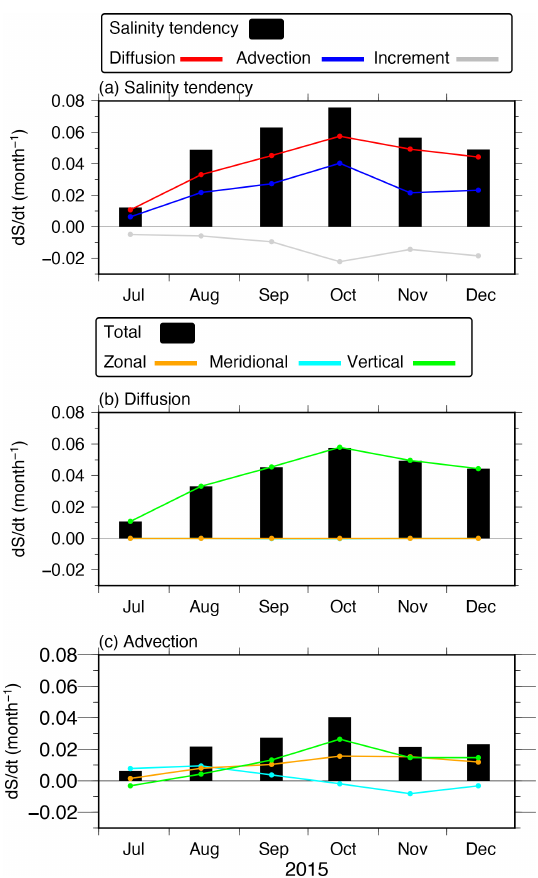
Figure A1. (a) Monthly mean for each term in the salinity budget equation (Eq. 5) averaged over the KE region in the intermediate layer (30–40 ◦ N, 140–160 ◦ E; 500–1000m depth) in the CTL run: the salinity tendency term (the LHS term; black bars), the salin- ity diffusion term (the first term on the RHS; red line), the salinity advection term (the second term on the RHS, blue line), and the salinity analysis increment term (the last term on the RHS; gray line). Panels (b) and (c) are the same as panel (a) but for the salinity diffusion and advection terms (black bars), respectively, as well as the zonal (orange lines), meridional (cyan lines), and vertical (green lines)